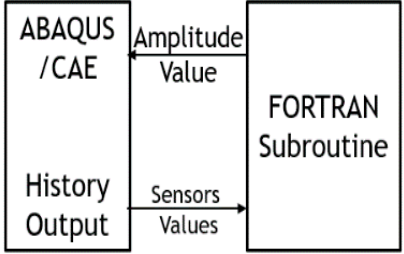
Figure 17. Workflow of the program.